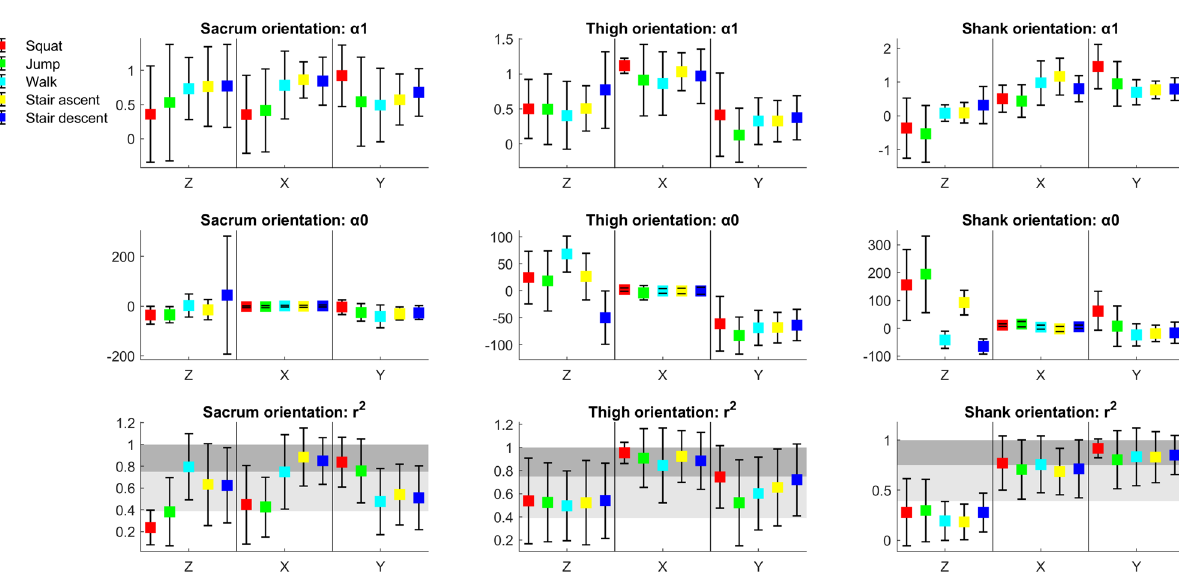
Figure 2. Means (squares) and standard deviations (markers) of α1, α0 and r 2 for individual participants’’ orientation waveforms; light grey shaded areas indicate fair-to-high concurrent validity; dark grey shaded areas indicate excellent concurrent validity; if DOT is identical to MTw then the values of LFM parameters are α1 = 1, α0 = 0, r 2 = 1, for the full interpretation of the parameter’s values, please see statistical analyses in the methods